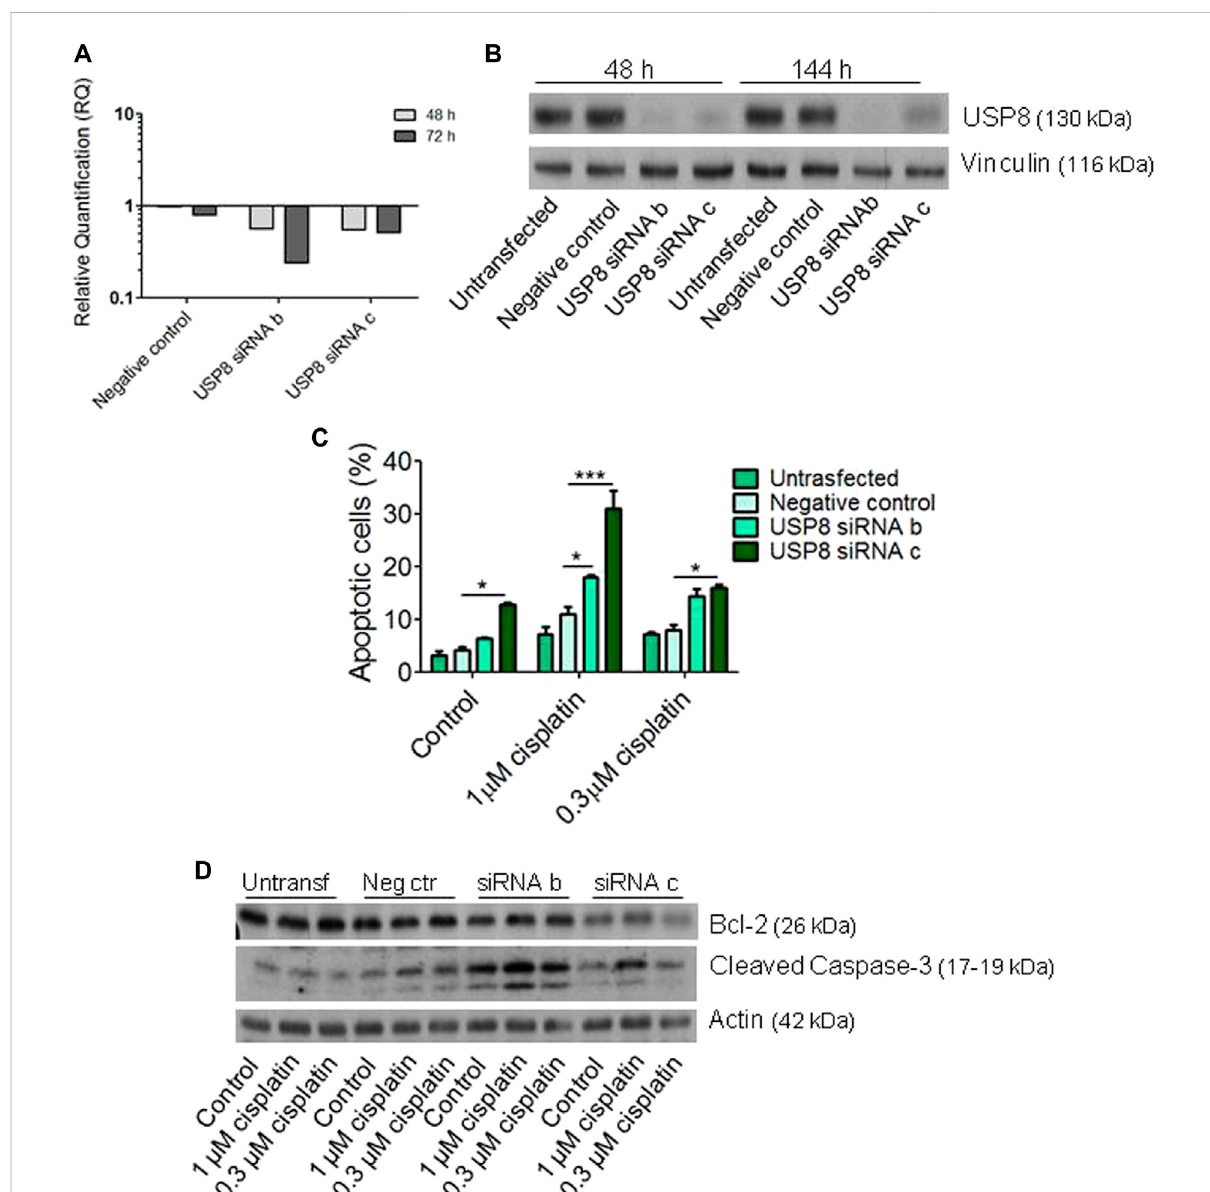
FIGURE 5 Molecular targeting of USP8 in PEO1 cells. (A) Quantitative RT-PCR of USP8 mRNA levels in PEO1 at different experimental time points after siRNA transfection; untransfected cells were the calibrator; GAPDH was used as housekeeping gene. (B) USP8 protein levels were analyzed by westernblotatdifferentexperimentaltimepointsafter siRNAtransfection.Theexperimentisrepresentativeofthree.Vinculinrepresentstheloading control. Quanti fi cation of the band intensity was performed using ImageJ, with normalization to vinculin. The obtained values are reported in theSupplementaryFigureS4 (C) ApoptosisanalysisofUSP8-silencedcellsbyAnnexin-Vbindingassay48 haftertransfectionstartincellstreatedfor 72 h with cisplatin. The columns indicate late apoptosis (Annexin V-PI positive cells). The reported values are the mean ± SD of three technical replicates. (D) Bcl-2andcleavedcaspase3proteinlevelsinUSP8-silencedPEO1cells.Forty-eighthaftertransfectionstart,cellsweretreatedfor72 h with cisplatin and then lysed. The quanti fi cation of the band intensity was carried out using ImageJ, with normalization to actin. The obtained values are reported in the Supplementary Figure